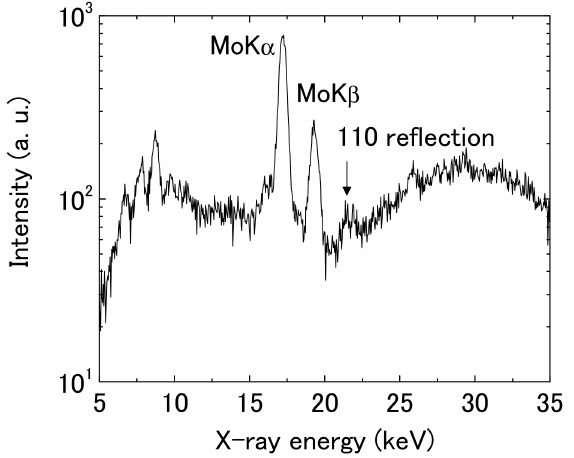
Figure 7. A typical energy dispersive diffraction spectrum of the friction-transferred PT